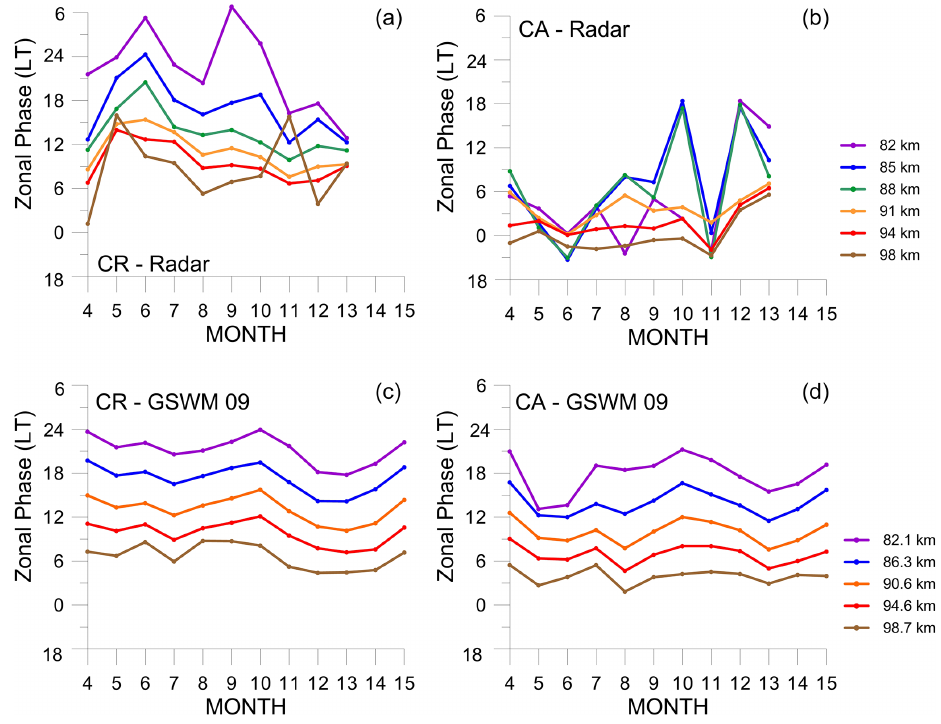
Figure 5. Zonal diurnal phase in LT for CR (a) and CA (b) from April 2005 to January 2006 and GSWM-09 for CR (c) and CA (d) from April to March. The height gates for the radar data and the GSWM-09 data are not quite the same but close enough for visual